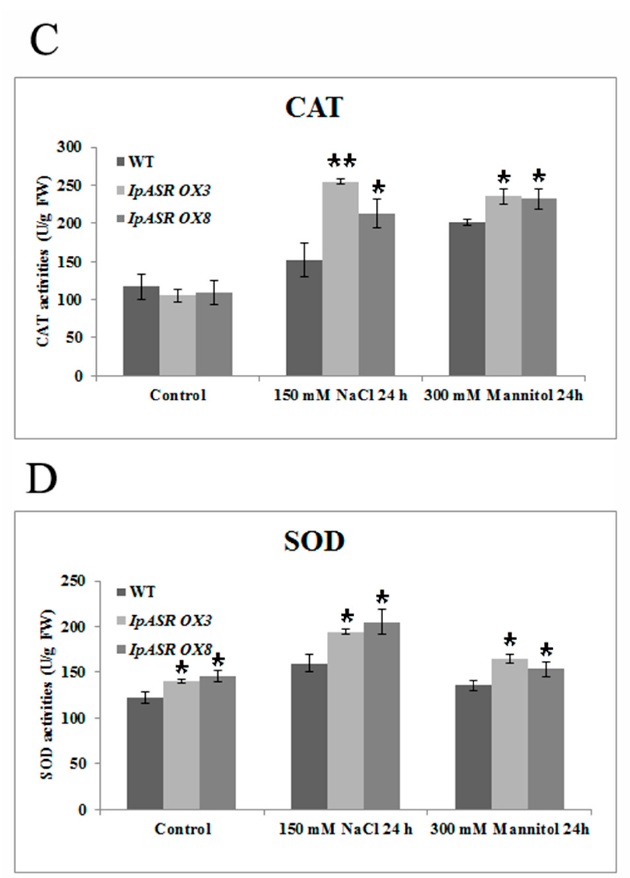
Figure 13. Oxidative stress analyses of transgenic overexpression lines and WT plants. Histochemical staining assays were used to detect H 2 O 2 and O 2 − by DAB ( A ) or nitro-blue tetrazolium (NBT) ( B ) staining, respectively. ( C ) Analysis of catalase (CAT) activity in the WT and transgenic lines under normal conditions and osmotic stress; ( D ) Analysis of superoxide dismutase (SOD) activity in the WT and transgenic lines under normal conditions and osmotic stress. Error bars indicate the SD based on over three replicates ( n ≥ 3). Asterisks indicate significant differences from the control (Student’s t -test p values, * p < 0.05 and ** p < 0.01).